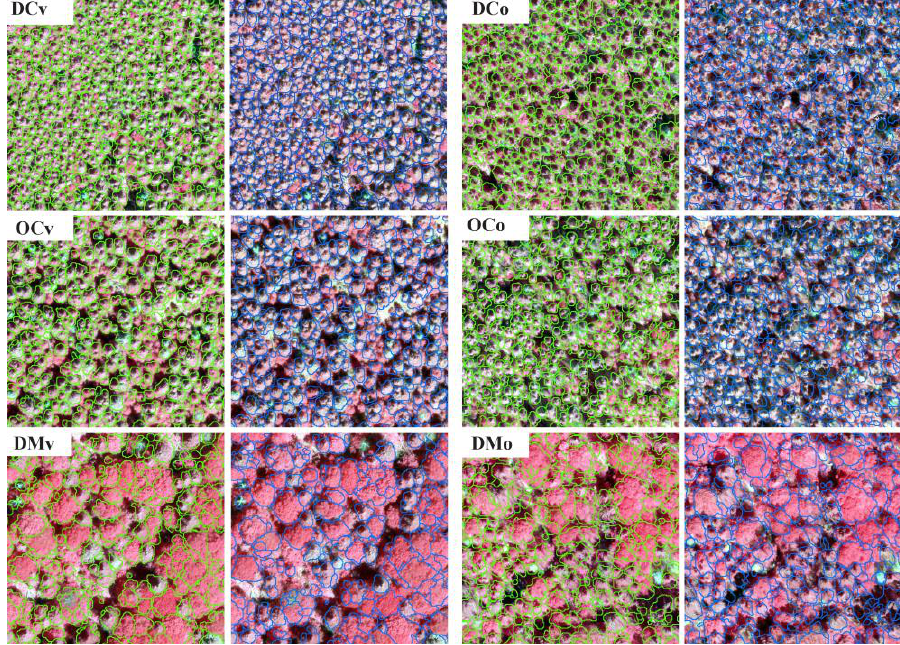
Figure 7. Crown delineation results for lidar (green outlines) and PPC-based CHMs (blue outlines). All image excerpts are 65 m × 65 m (DC: dense conifers, OC: open conifers, DM: dense mixed woods, v: vertical, o: